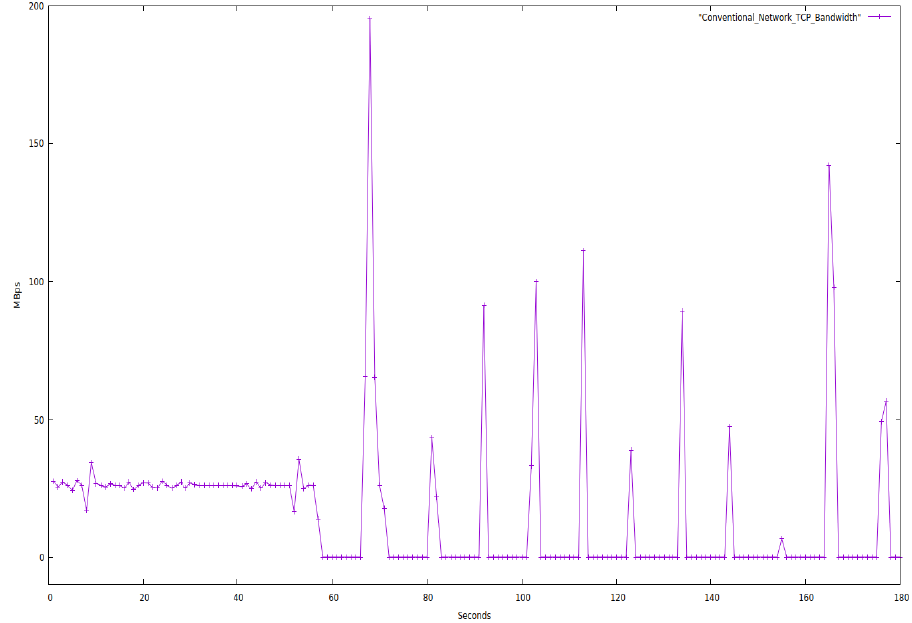
Figure 5. Traditional Network TCP Bandwidth Fluctuation.